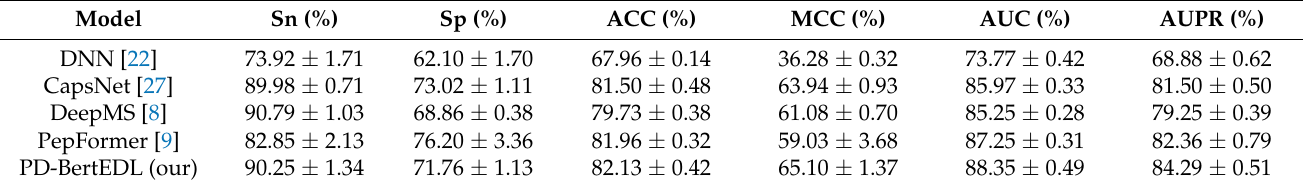
Table 5. The results of 5-fold cross-validation with different models on Homo sapiens dataset.